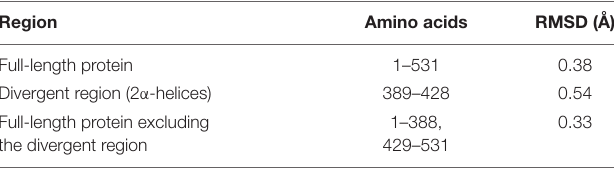
TABLE 1 | RMSD generated using Pymol standard algorithm.